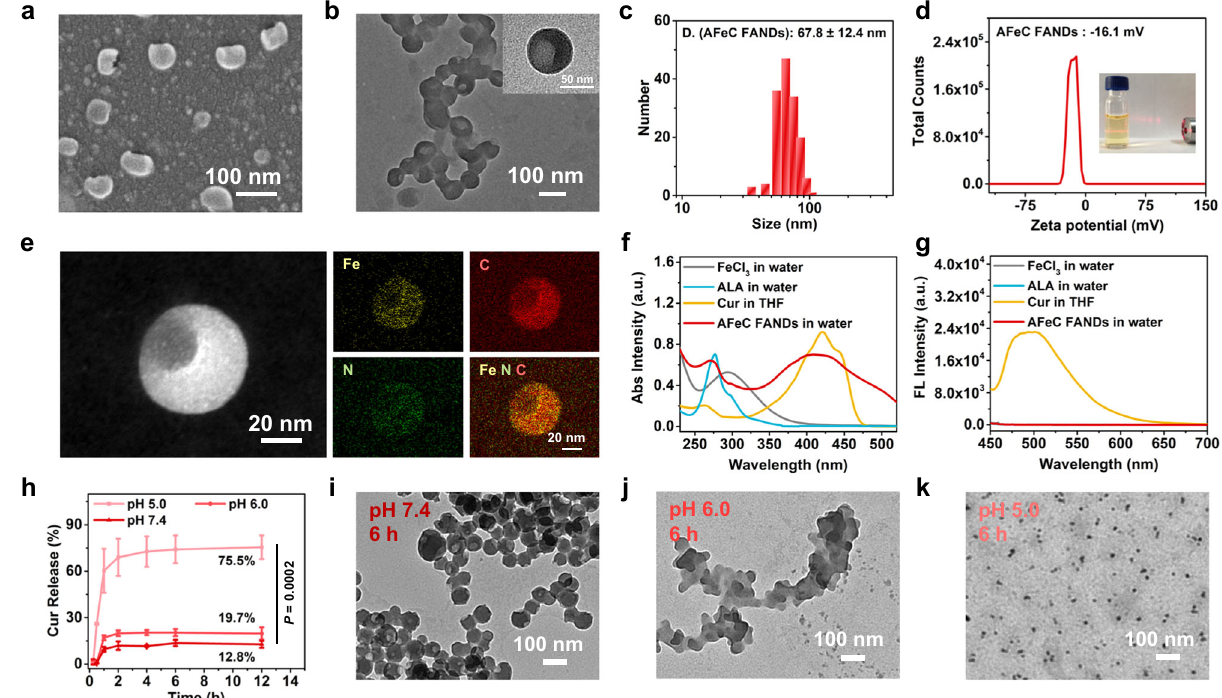
Fig. 2 | Preparation and characterization of the AFeC FANDs. a SEM and b TEM images of the AFeC FANDs. c Size distribution ofthe AFeC FANDs. d Zeta potential of the AFeC FANDs, inset is their Tyndall effect exhibition. e Element mapping for Fe, C, and N of the AFeC FANDs. f UV-vis absorption (Abs) and g fl uorescence (FL) spectra of the free FeCl 3 , 5-aminolevulinic acid (ALA), curcumin (Cur), and AFeC FANDs. h In vitrorelease of CurfromtheAFeC FANDsinthebuffersolutionsof pH